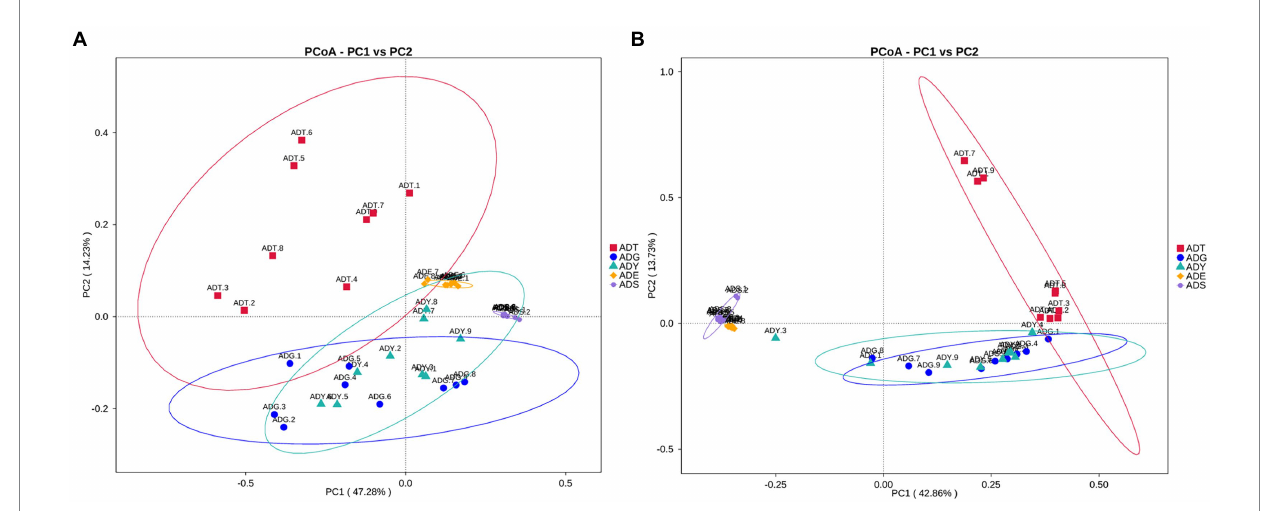
FIGURE 5 PCoA analysis of the intestinal microbial community in different groups. (A) PCoA map on the basis of weighted UniFrac distance. (B) PCoA map on the basis of unweighted UniFrac distance.